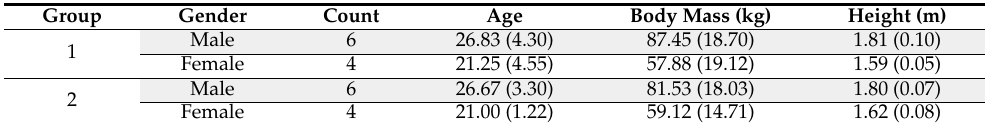
Table 2. Summary of anthropometric information for the subjects. The values in columns 3–5 are the average. (standard